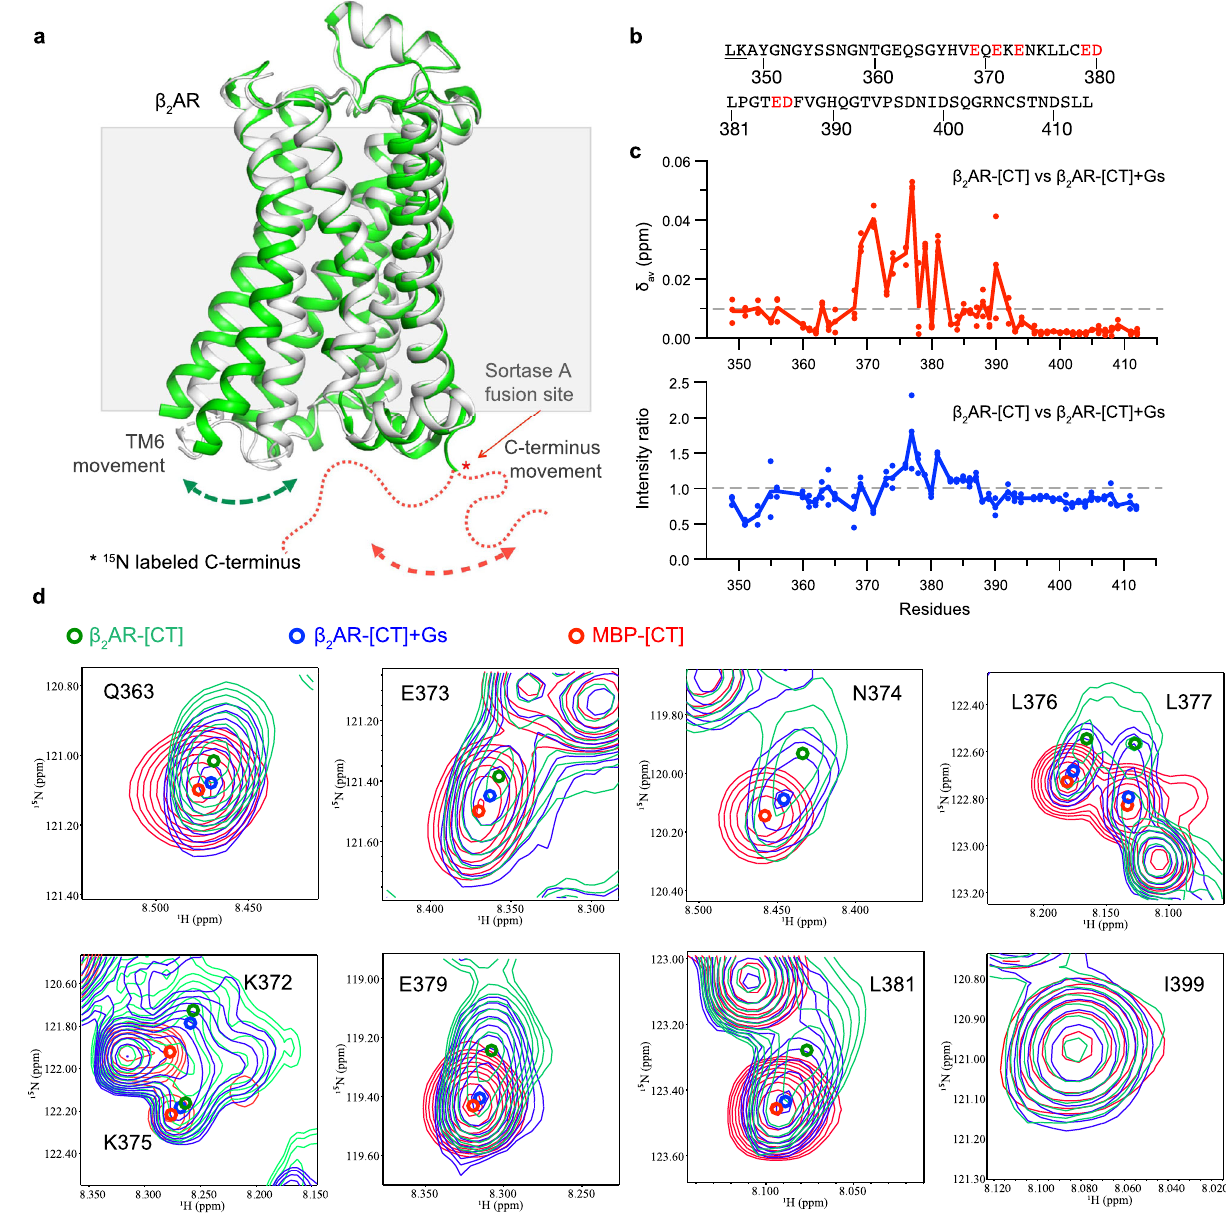
15 N β 2 AR-[CT] residue (347-413) in the absence and presence of Gs protein. Weighted average 1 H – 15 N chemical shift changes were calculated as Δδ av = (( Δδ H ) 2 + ( Δδ N /5) 2 ) 1/2 .Theintensityratiowascalculatedas I R-Gs /I R .Dotsonthecurveindicate two sequential 8h of measurements of spectra and the merged spectrum. d The spectraofagonist- β 2 AR-[CT]-GscomplexismoresimilartothespectraofMBP-[CT] thanthe β 2 AR-[CT].Representativepeaksfromsuperposed 1 H – 15 NHSQCspectraof 15 N MBP-[CT], BI occupied 15 N β 2 AR-[CT], and BIoccupied 15 N β 2 AR-[CT] coupledto nucleotide-free Gs. The peak centers are shown as colored